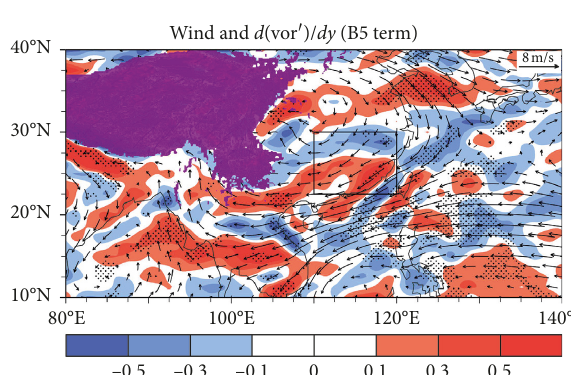
Figure 10: The diagnosis of B 5 related to the EMI index, anom- alous relative vorticity advection transported by basic meridional wind (vector: basic meridional wind, unit: ms − 1 ; shading: z ζ g unit: 10 − 11 m − 1 s − 1 ). The vorticity perturbation is the regression · coefficient of the vorticity regression on the standardized EMI index. The dotted areas are through the 90% confidence t